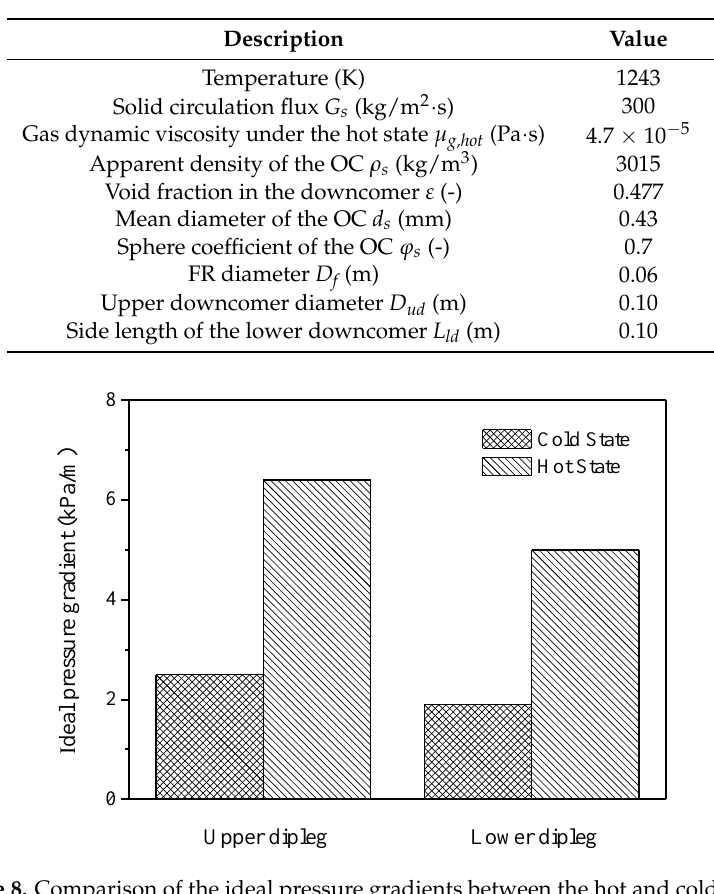
Table 3. Parameters for the calculation of the ideal pressure gradients under the hot state.